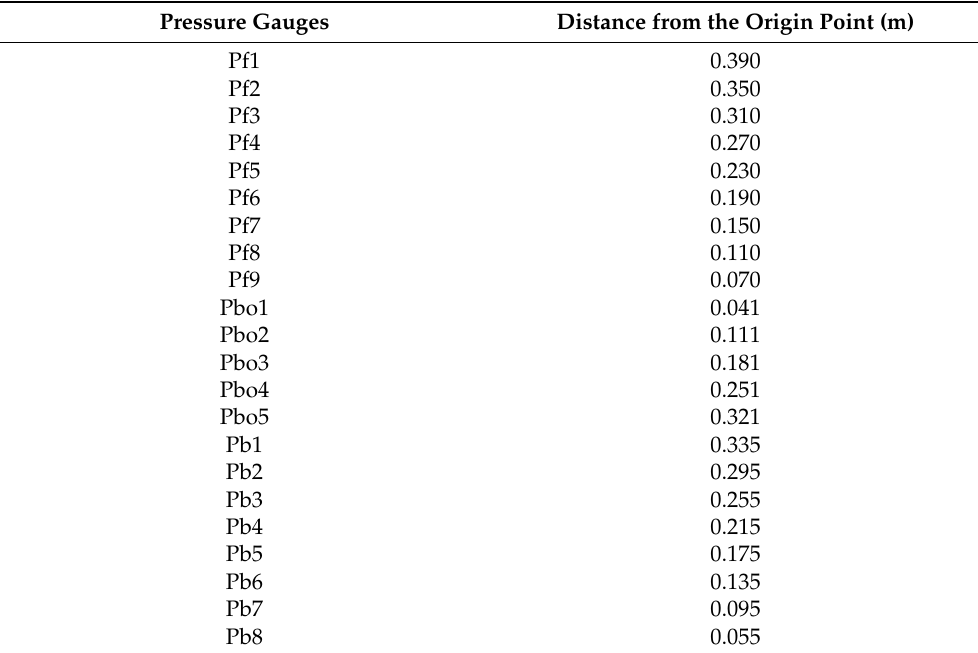
Figure 3. Wave forces acting on caisson breakwater. Table 2. Positions of pressure Table 1. Wave conditions used in experiment.